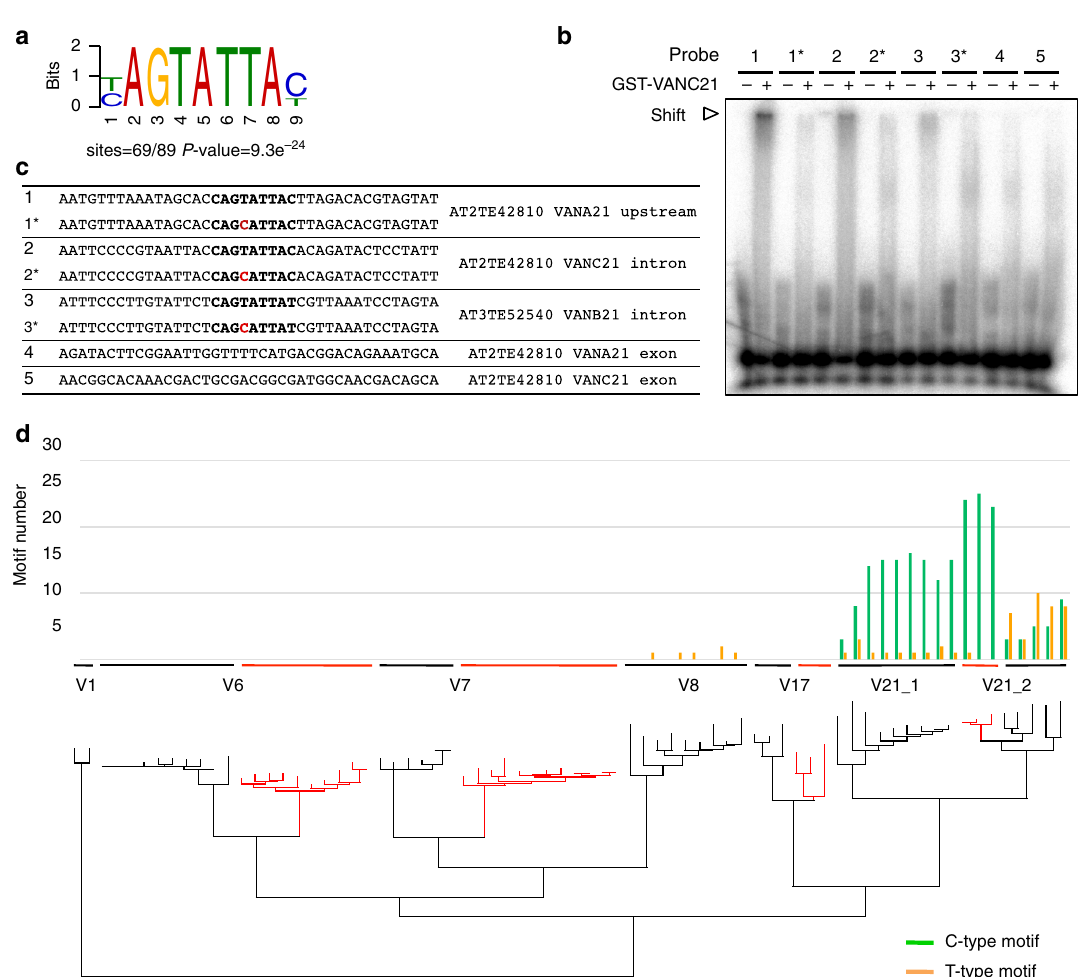
Fig. 3 VANC21-binding motifs and their distribution among VANDAL families. a DNA sequence motif most commonly found at FLAG-VANC21-binding sites in VANDAL21 TEs. Localizations of the motif are shown in Fig. 2b and Supplementary Fig. 6, with green and orange bars indicating positions of the C- type ( “ YAGTATTAC ” ) and T-type ( “ YAGTATTAT ” ) motifs, respectively. b Electrophoretic mobility shift assay (EMSA) by VANC21 protein for double- stranded DNA of the sequences shown in c . The probe sites are also shown by white arrowheads in Fig. 2b. 1*, 2*, and 3* have single-base substitutions within the motif relative to the original sequences. 4 and 5 are control sequences from the exons, where VANC21 localization was not detected. Results for dependence of the shift to the protein amount and a competition assay are shown in Supplementary Fig. 7. c Sequences of the dsDNA probe used in EMSA ( b ). d Numbers of C- and T-type motifs within VANDAL21 and related VANDAL family members within the genomes of A. thaliana and A. lyrata. A. lyrata - speci fi c lineages are shown with red lines. IDs for these TE copies and bootstrap probabilities are shown in Supplementary Fig.